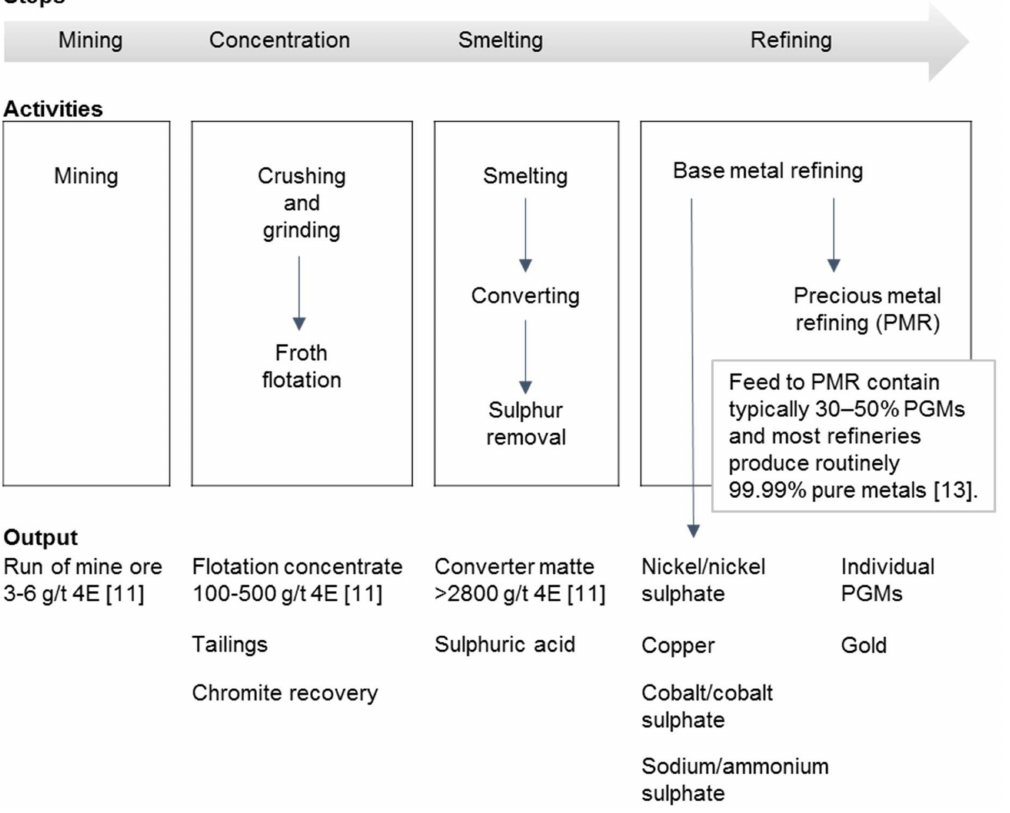
Figure 1. Simplified platinum group metal (PGM) processing chain (conventional matte smelting treatment). 4E = Pt, Pd, Rh, and Au. Adapted from Ndlovu [11] and Cramer